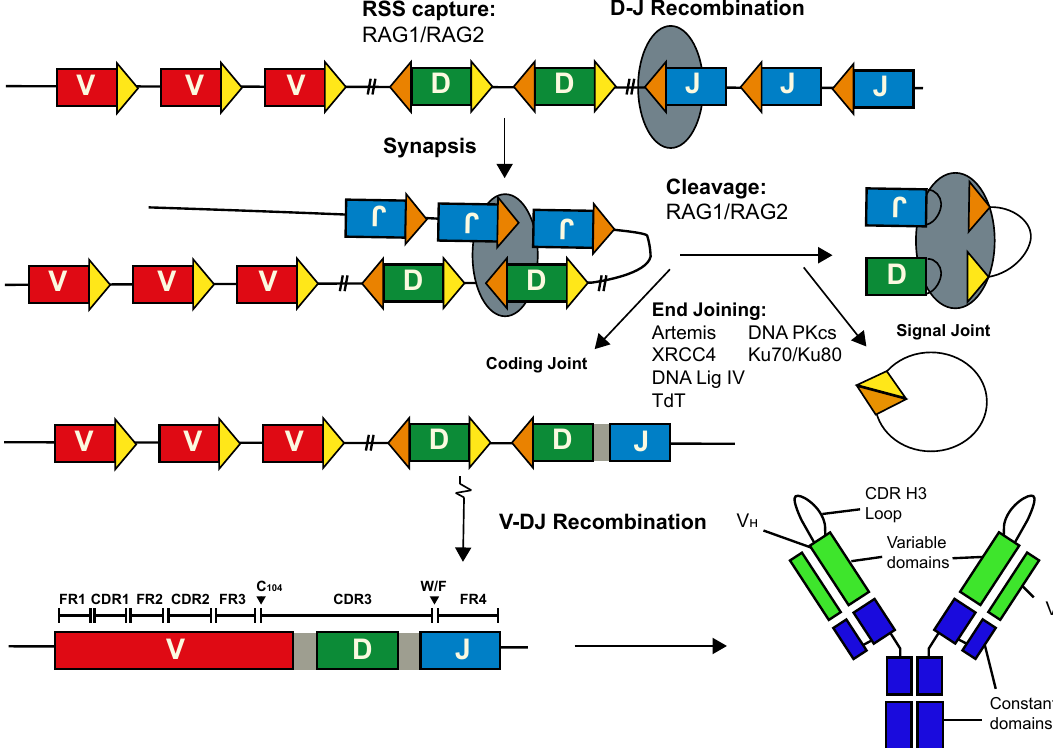
Figure 1. Assembly of Immunoglobulin Genes by V(D)J recombination. V(D)J recombination is a step-wise process that produces a contiguous variable exon from distinct germline segments. The complementarity determining region 3 of the heavy chain is encoded by the 3 (cid:48) sequence of the V gene segment, the entire D gene segment and sequences at the 5 (cid:48) end of the J segment. The framework and complementarity-determining regions are labelled, while the conserved features that demarcate the immunoglobulin heavy chain CDR H3 are indicated. The gaps between gene segments, shaded light grey, represent N-nucleotides. RAG1 and RAG2 proteins are depicted as a dark grey oval; proteins involved in end joining, Ku70 / Ku80 heterodimer, Artemis, DNA protein kinase catalytic subunit (DNA-PKcs), Terminal deoxynucleotide transferase (TdT), X-ray repair cross complementing protein 4 (XRCC4) and DNA ligase IV, are indicated. A functional B-cell receptor is generated following light chain recombination and the subsequent pairing of the heavy (V H ) and light (V L ) chains. In some cases, V(D)J recombination can generate long CDR H3 loops that form unusual paratope